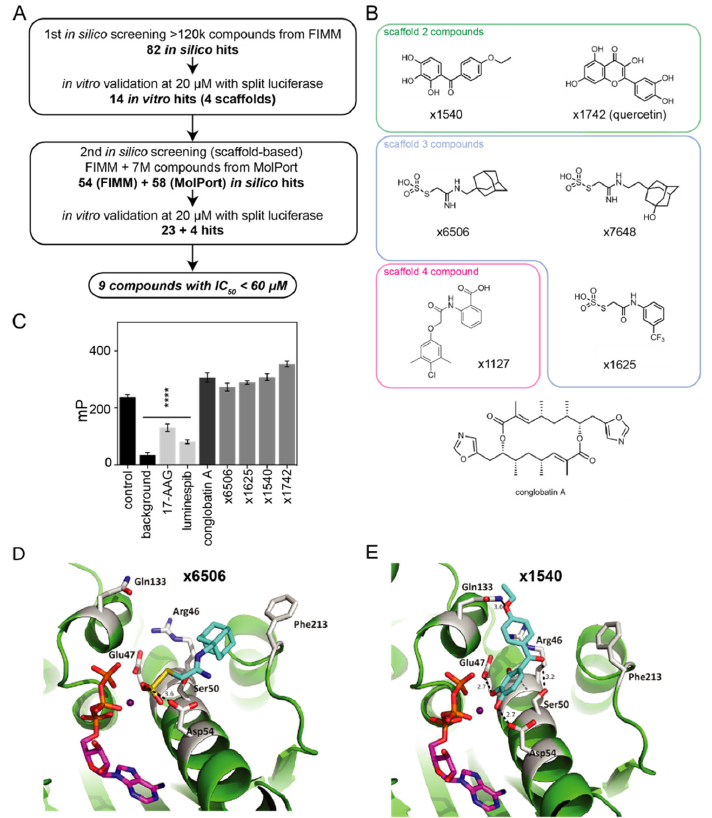
Figure 5. Screening for small molecule Hsp90/Cdc37 interface inhibitors. ( A ) Combined computa- tional and in vitro compound screening workflow to identify novel small molecules with activities below 60 µ M in the Hsp90/Cdc37 split Renilla luciferase assay. ( B ) Chemical structures of the selected top hit compounds, arranged by scaffolds. The structure of conglobatin A is shown for comparison at the bottom. ( C ) Competition with Hsp90 N-terminal ATP-binder FITC-geldanamycin decreases the polarization signal, indicating ATP-pocket binding (with 17-AAG, luminespib as positive controls). All of the compounds were tested at 20 µ M. ( D , E ) The docked models for × 6506 ( D ) and × 1540 ( E ) in a complex with human N-Hsp90 (green; PDB ID 3T0Z) at the Hsp90/Cdc37 interface. Both compounds are shown as cyan sticks, the interacting residues in Hsp90 are shown as gray sticks, ATP is shown as magenta sticks, and magnesium is shown as a deep purple sphere. The polar interactions between the compounds and the protein are shown as dashed lines with distances in Ångströms. **** p <